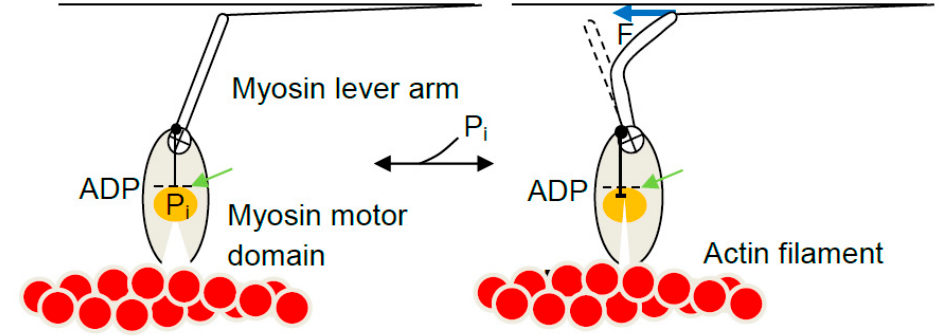
Figure 7. Tentative force generating mechanism of the Eyring type. A small structural change in the motor domain close to the ATPase site (green arrow) is amplified (by rotation of circle with cross) to strain an elastic element (tentatively by bending the lever arm). In the absence of resisting tension the entire lever arm relaxes into the post-power-stroke orientation. Pi: inorganic phosphate.